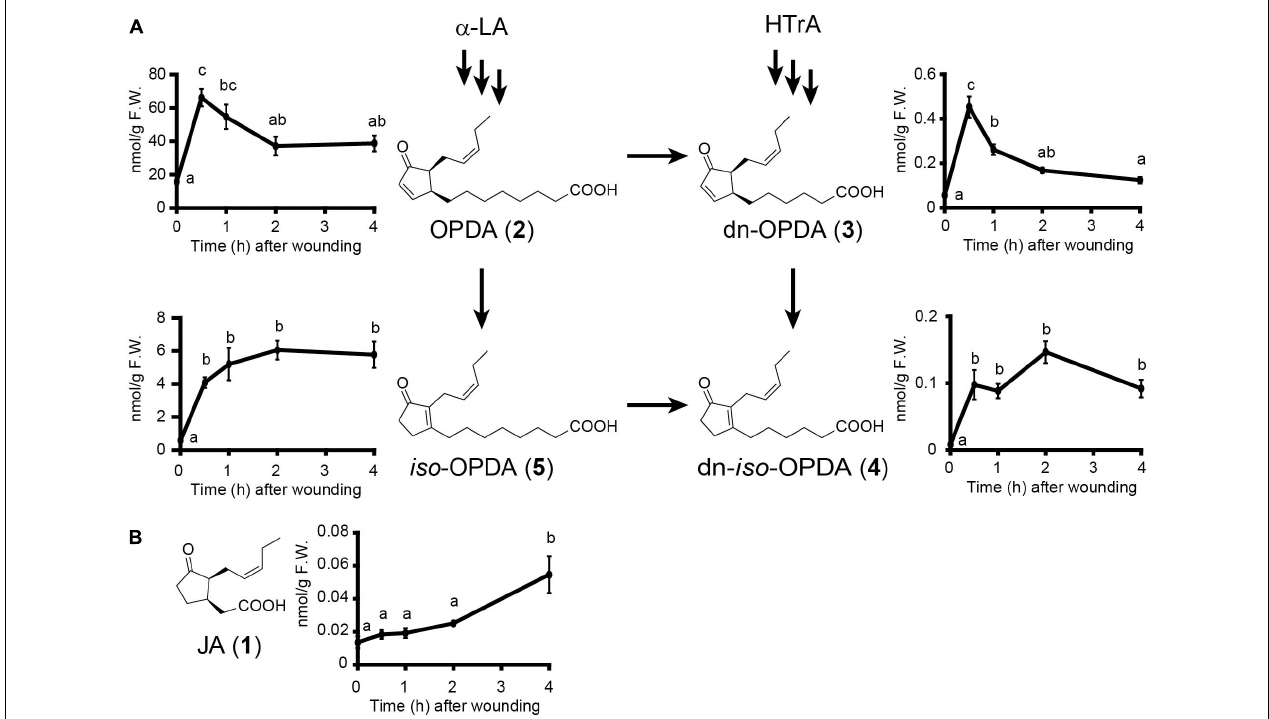
FIGURE 3 | Effects of wounding on accumulation levels of endogenous OPDA, iso -OPDA, dn-OPDA, dn- iso -OPDA (A) , and JA (B) . (A) Values indicate the amount of OPDA, iso -OPDA, dn-OPDA, and dn- iso -OPDA in C. plumiforme gametophores after wounding ( n = 3). (B) Values indicate the amount of JA in C. plumiforme gametophores after wounding ( n = 3). Arrows indicate the proposed biosynthetic pathways in M . polymorpha. Bars indicate standard errors of the means. Statistically different data groups are indicated with different letters ( p < 0.05, one-way ANOVA with Tukey’s post hoc test). LA, linolenic acid; HTrA, hexadecatrienoic